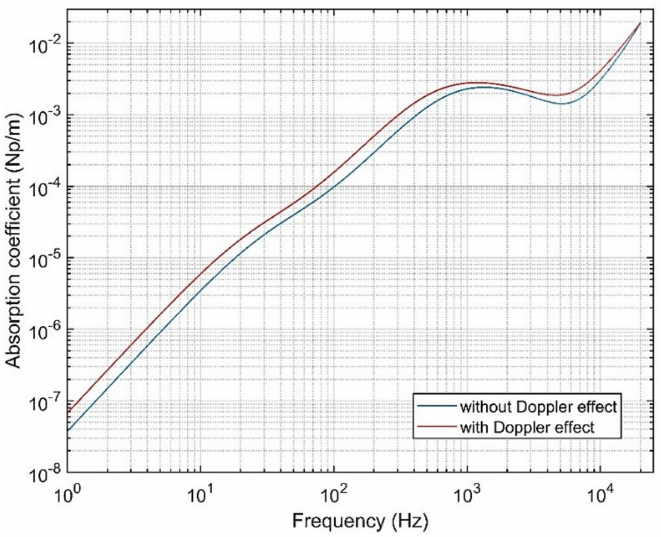
Figure 7. Variation of absorption coefficient with